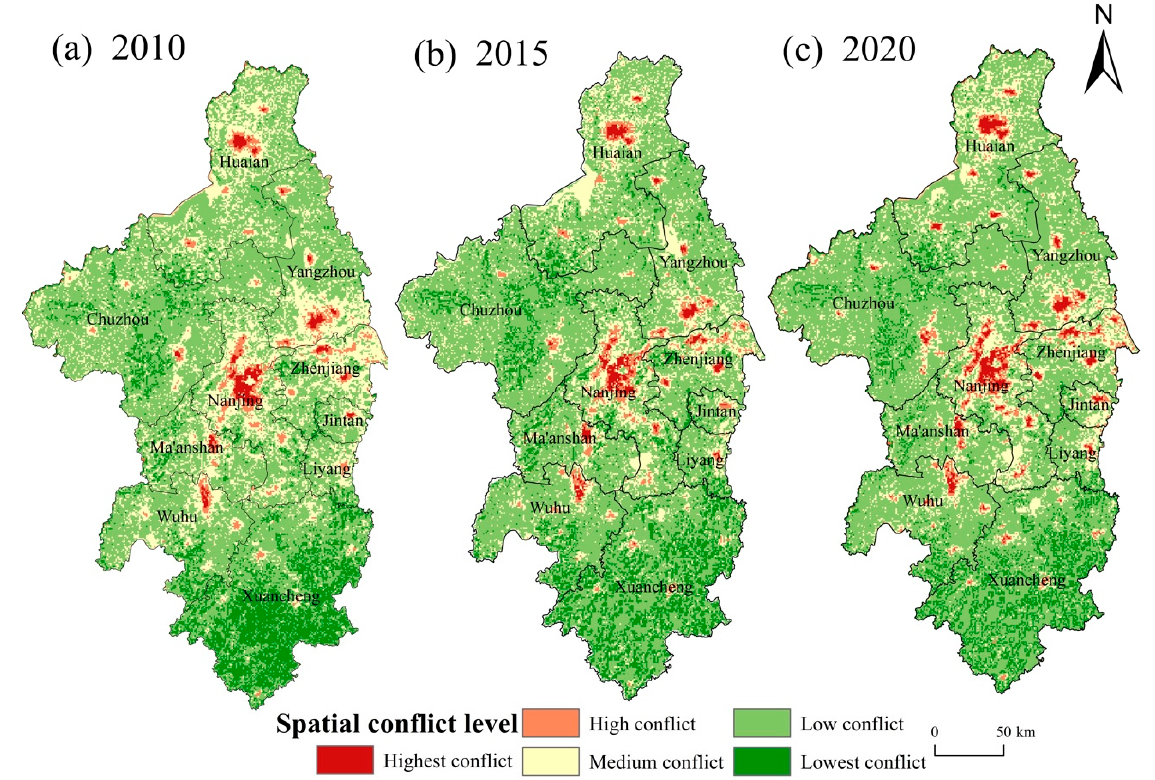
Figure 5. Distribution of ecological-economic spatial conflict in Nanjing metropolitan area. ( a ) 2010 spatial conflict map; ( b ) 2015 spatial conflict map; ( c ) 2020 spatial conflict map.